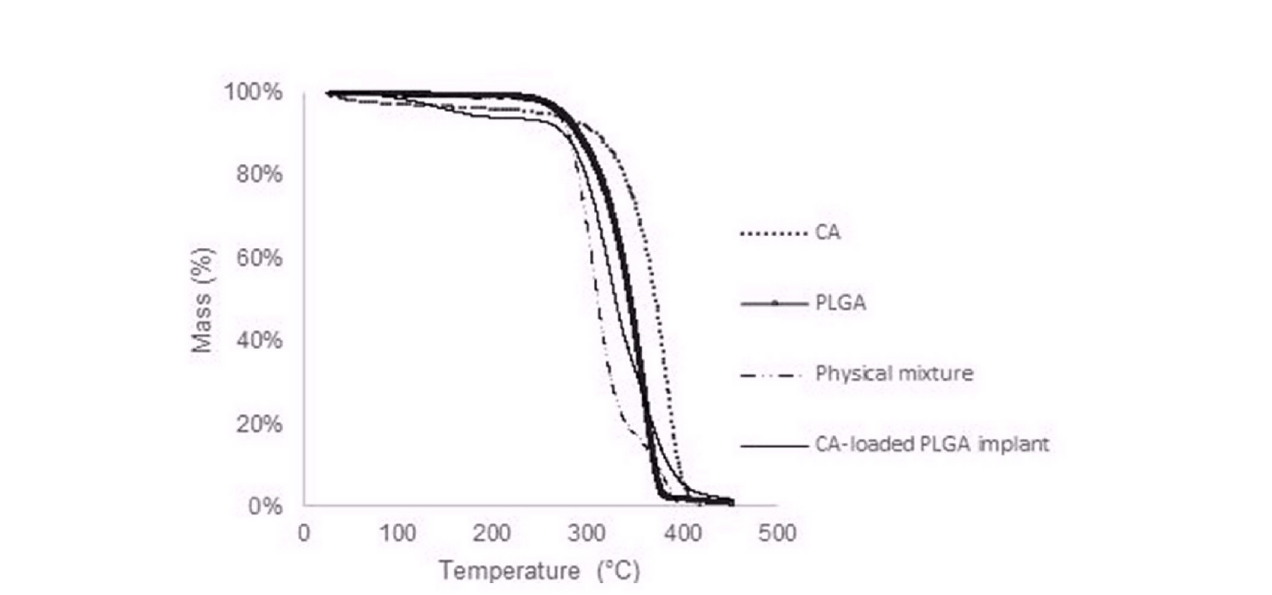
FIGURE 3 - TG curves of CA, PLGA, physical mixture, CA-loaded PLGA implant.